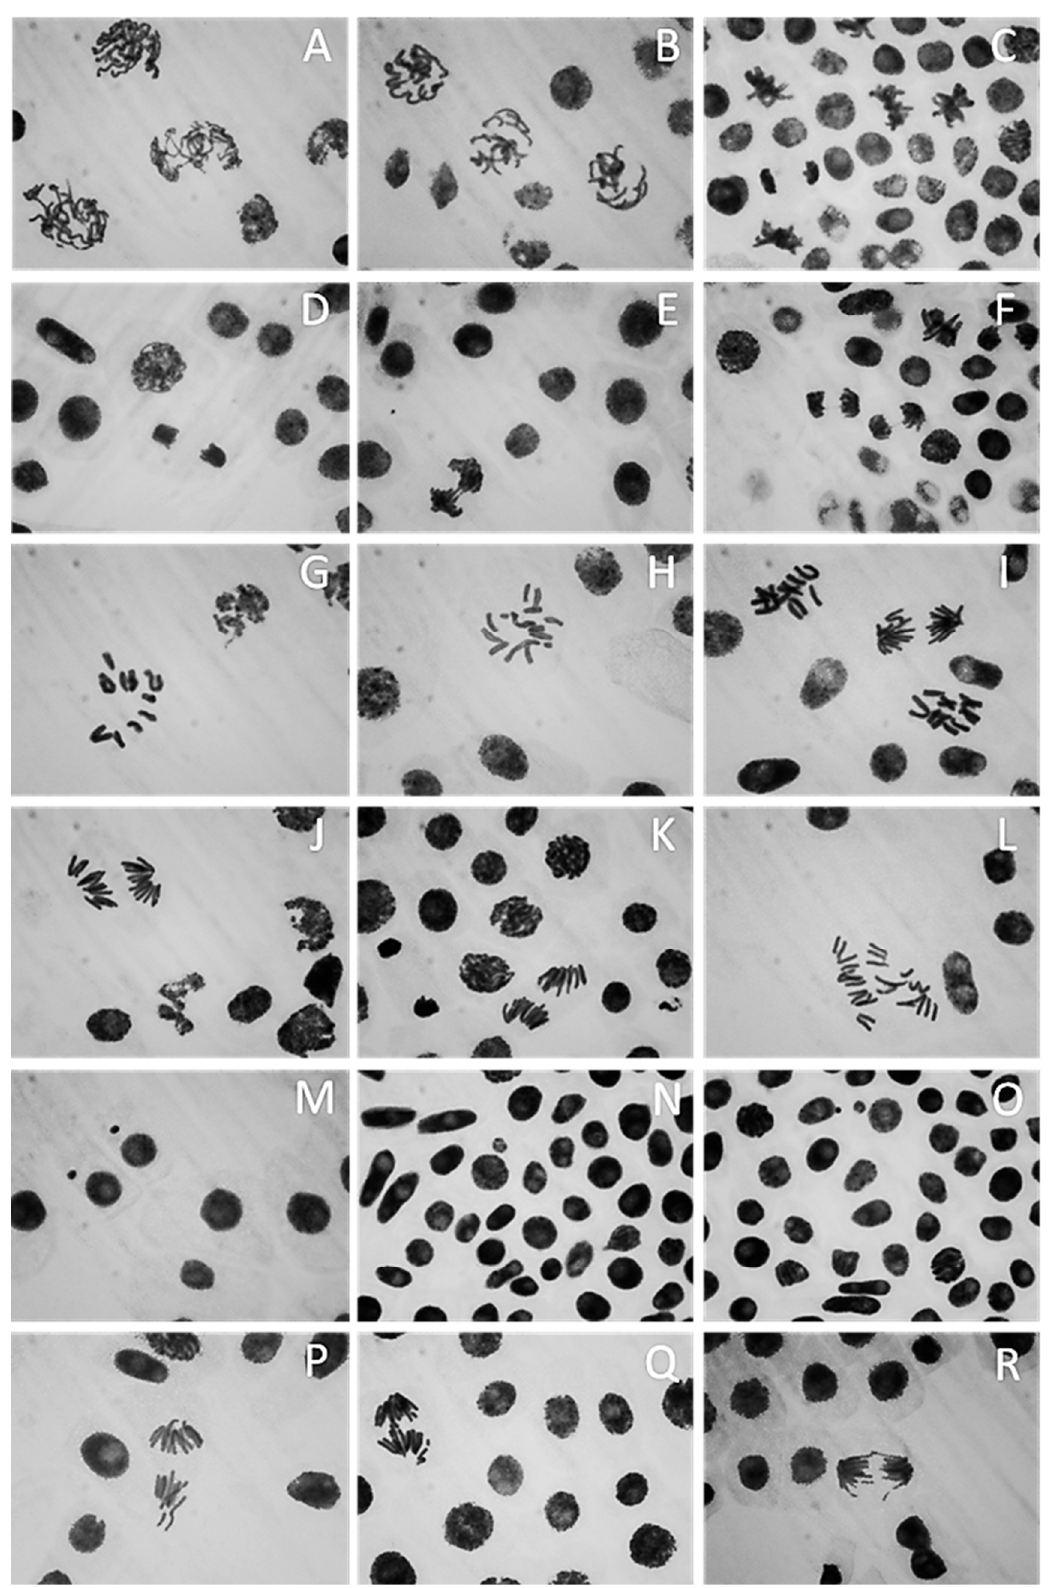
Figure 11. Different treatments of ZnO nanoparticles caused anomalies in Vicia faba root meristems: ( A , B ) irregular prophase; ( C – F ) sticky chromosome (prophase, anaphase and telophase with bridges, respectively); ( G – I ) C ‐ metaphase; ( J , K ) disturbed anaphase, ( L ) C ‐ anaphase; ( M – O ) micronucleus at interphase; ( P – R ) chromosome breakage and forward at anaphase.